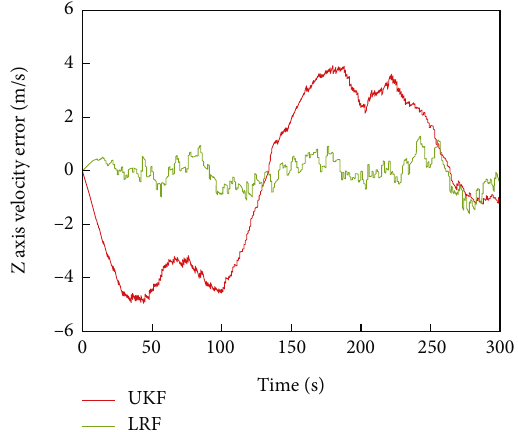
Figure 16: Pitch angle error contrast